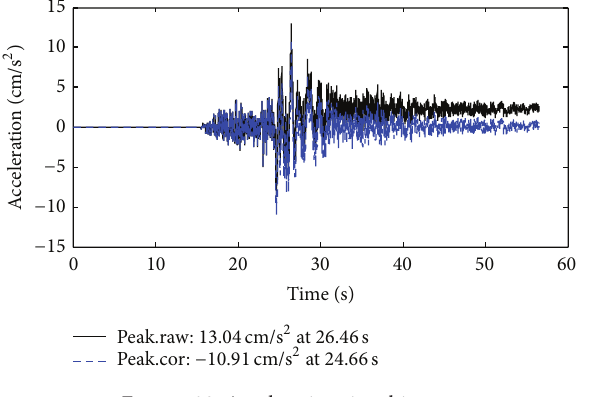
Figure 20: Acceleration time history.